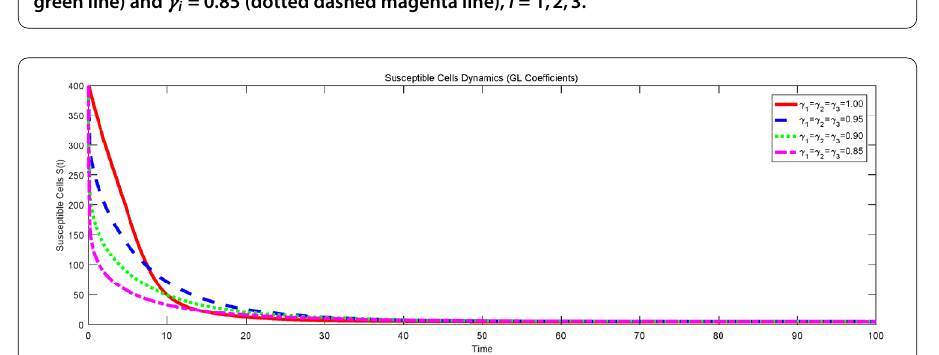
Figure 7 Dynamics of V ( t ) with γ i = 1 (solid red line), γ i = 0.95 (dashed blue line), γ i = 0.9 (dotted green line) and γ i = 0.85 (dotted dashed magenta line), i = 1,2,3.